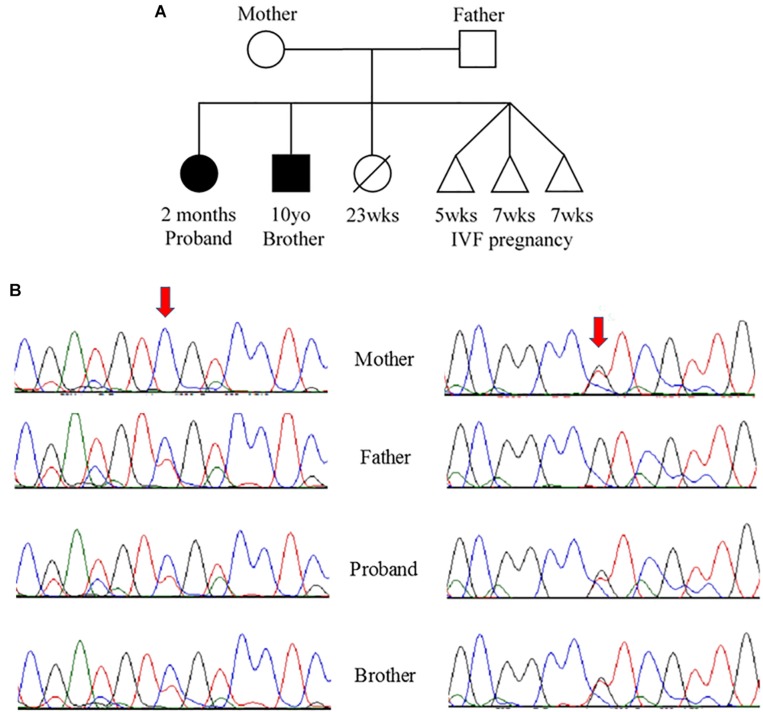
(A) Pedigree and (B) Sanger sequencing. (A) Family pedigree showing the proband and similarly affected brother (black shading). There was a prior loss of a severely premature live birth and three prior failed IVF pregnancies. (B) Sanger sequencing data from the four available family members. Red arrows indicate residue of interest. The left side shows residues around the c.394G>A change that results in D132N in one of the two alleles for TNNC1 for three of four individuals (mother is reference, other three are heterozygous for the variant). The right side shows residues around the c.435C>A change that results in D145E in one of the two alleles for TNNC1 for three of four individuals (father is reference, other three are heterozygous for the variant).